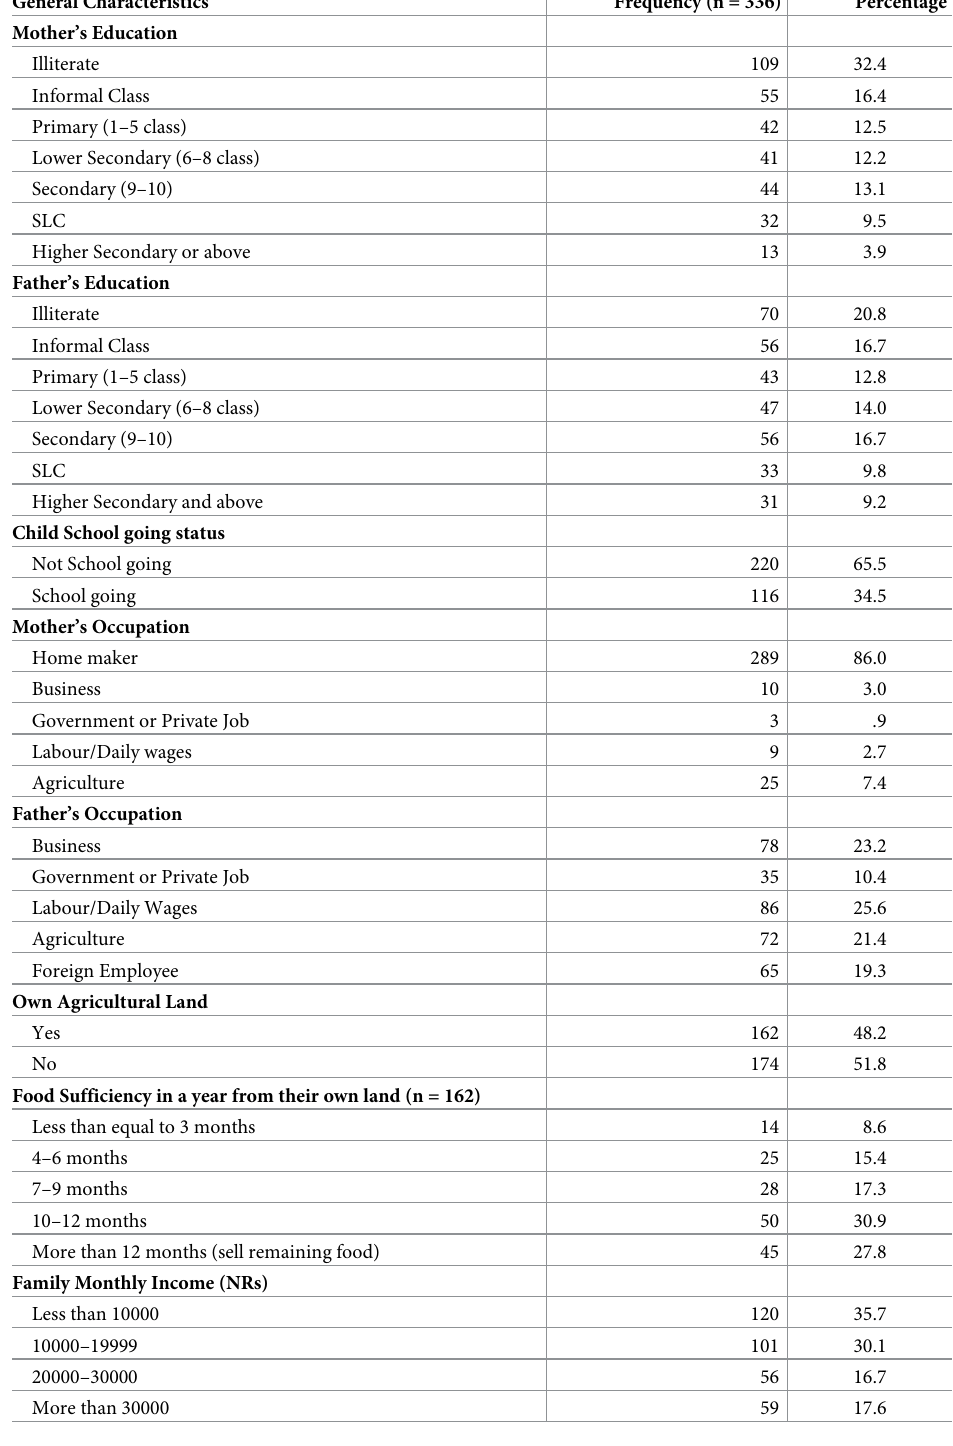
Table 2. Socio-economic characteristics of mothers of under-five Muslim children in Kapilvastu district